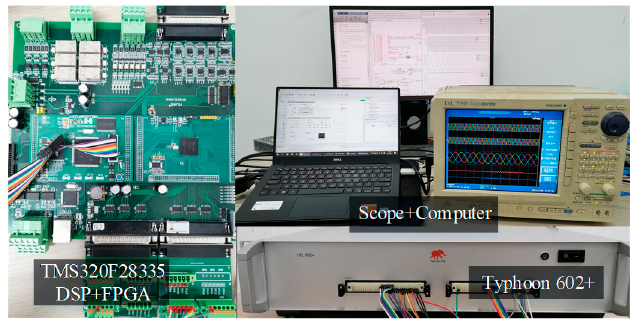
Figure 3. CHIL platform used in the following experiments. Table 1. Parameters of VSG controlled converter system.